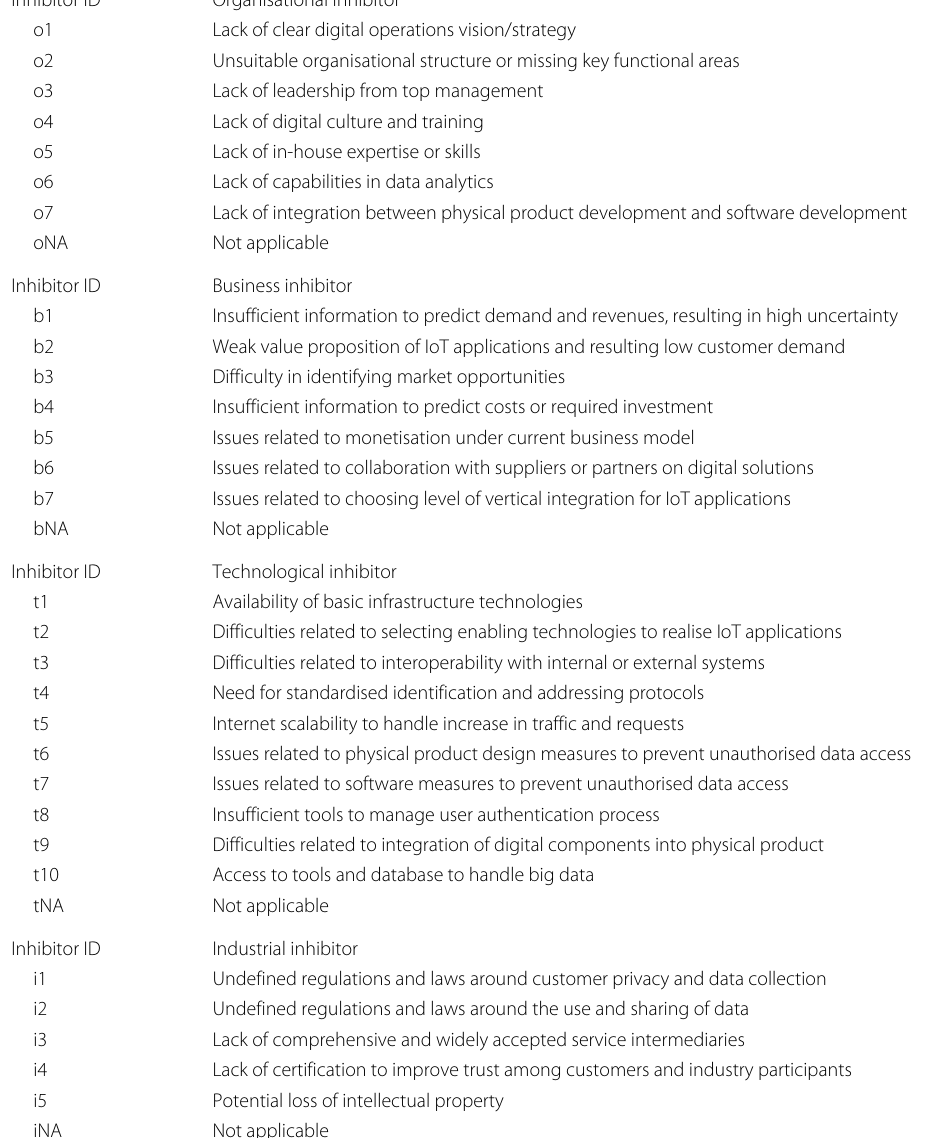
Table 3 Conceptual model covering inhibitors of development and deployment of IoT applications Inhibitor